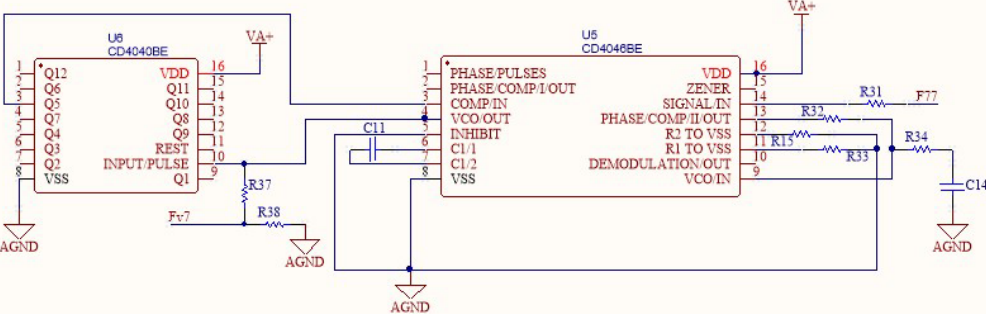
Figure 6. Schematic diagram of the frequency multiplication circuit.